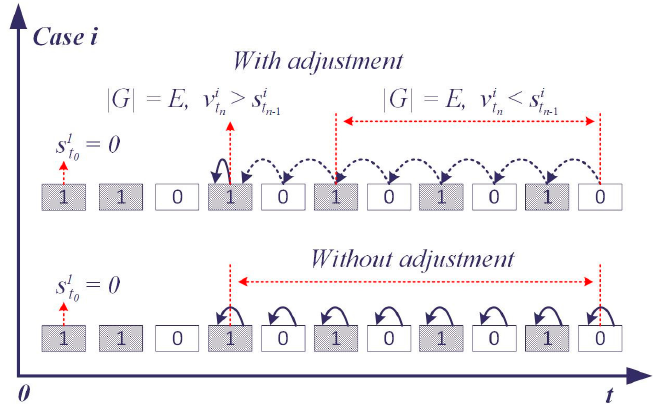
Figure 6. Adjustment of the assessment status.